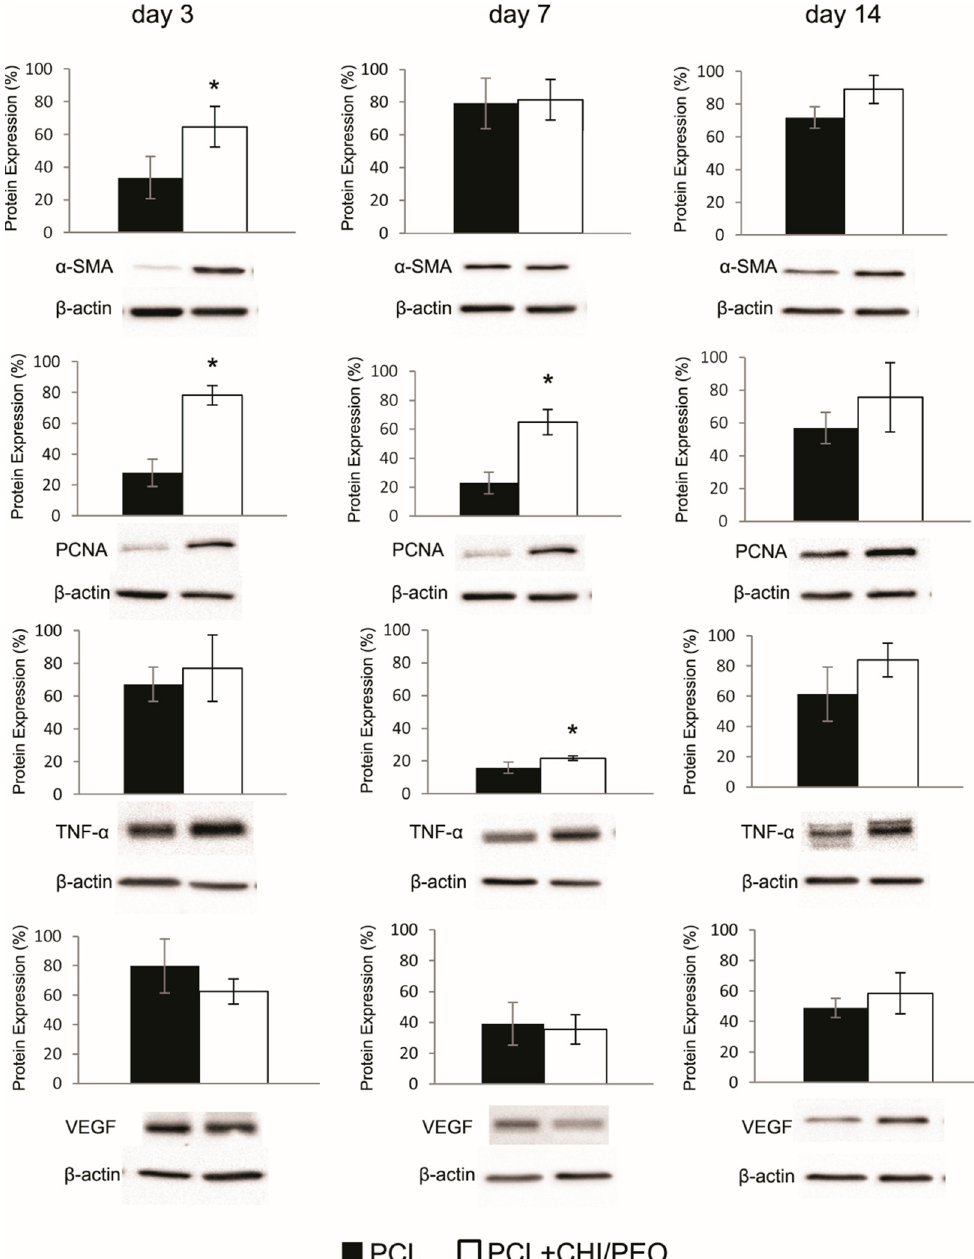
Figure 6. Western blot analysis and densitometric analysis of smooth muscle actin ( α -SMA), PCNA, Tumor Necrosis Factor (TNF- α ), and VEGF observed in the excision lesions of mice topically treated with PCL or PCL+CHI/PEO membrane on days 3, 7, and 14. The results were expressed as mean ± standard deviation. (*) p < 0.05 indicates statistically significant differences between treatments according to the Student’s t-test. ( n = 4–6). Protein expression levels were standardized against the internal β -actin expression levels of each sample.